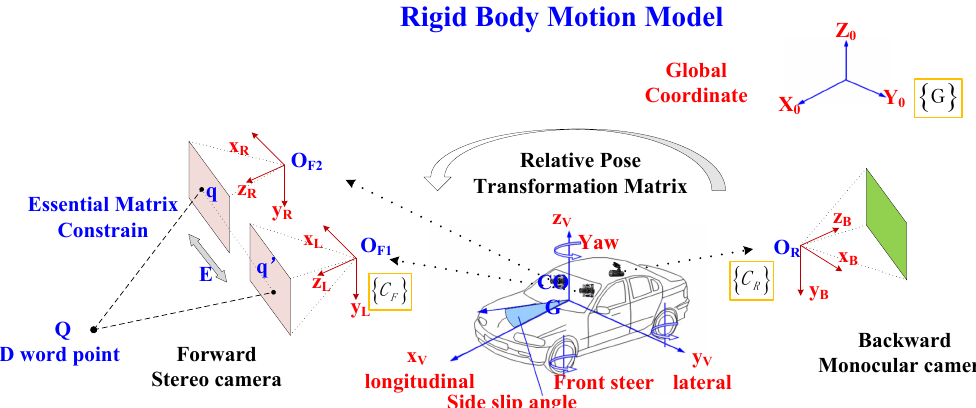
Figure 1. Coordinate system of rigid body motion model with forward stereo camera and backward monocular camera. Using the relative pose transformation matrix, we can transform the trajectories of backward monocular camera into the forward stereo camera Coordinate system. [Color figure can be viewed at www.mdpi.com].